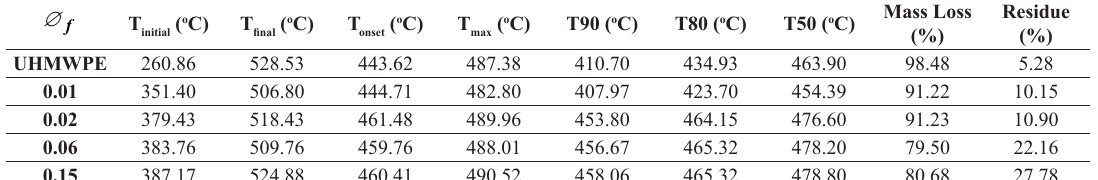
Table 3. TGA data of the pure UHMWPE and its composites.